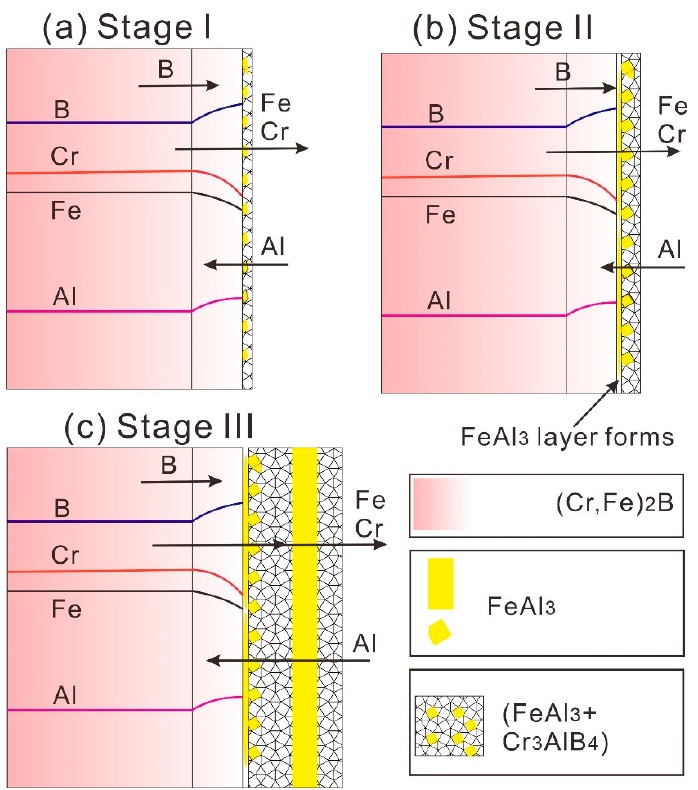
Figure 10. The schematic drawings showing the formation of the periodic-layered structure by the solid-(Cr, Fe) 2 B/liquid-Al reaction. ( a ) A thin (Cr 3 AlB 4 + FeAl 3 ) dual-phase layer was formed. ( b ) FeAl 3 grains conjunct into the thin plate within the dual-phase layer. ( c ) A new periodic pair is formed.